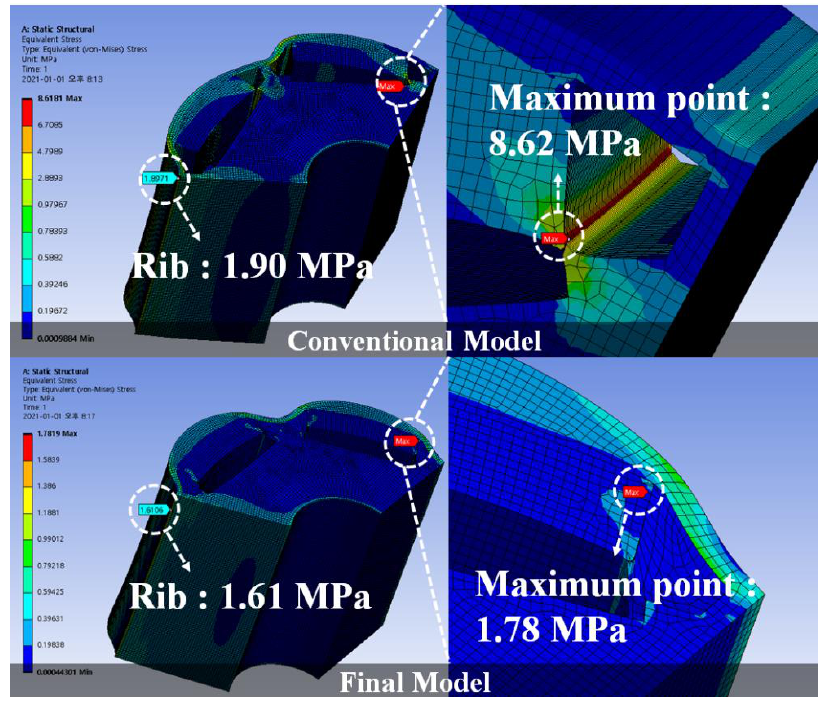
Figure 19. Comparison of the equivalent stress (4000 rpm).